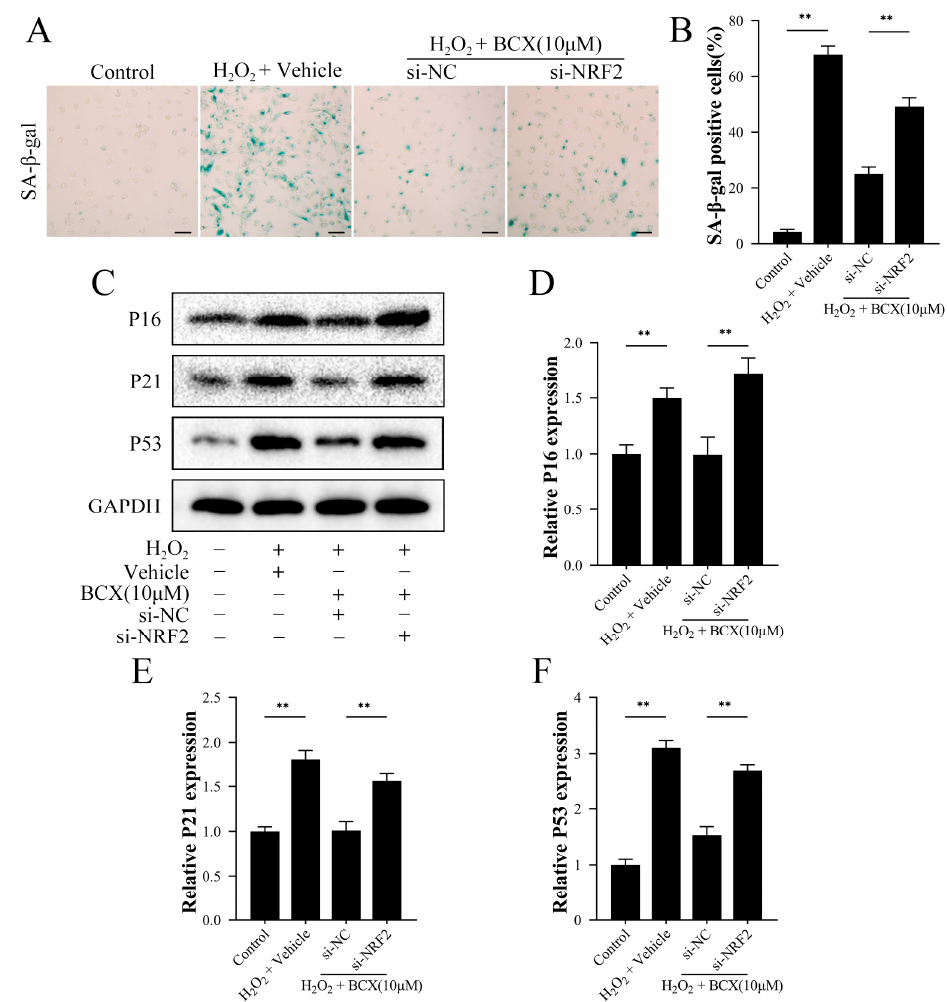
Figure 6. Inhibition of NRF2 reversed the ability of BCX to resist oxidative stress-induced senescence. HK-2 cells were transfected with negative control or si-RNA for NRF2 (si-NRF2). After transfection, HK-2 cells were pretreated with or without BCX (10 µ M) for 24 h and treated with 800 µ M H 2 O 2 for 48 h. ( A , B ) Senescence levels of HK-2 cells were detected by SA- β -galactosidase staining. Scale bar = 50 µm. ( C – F ) Western blot detection of protein expression of senescence-associated proteins P16, P21, and P53. The quantitative analysis was expressed as a relative value to GAPDH. Values are expressed as mean ± SD. The mean value is the average of the results of three replicate experiments. n = 3. ** p <